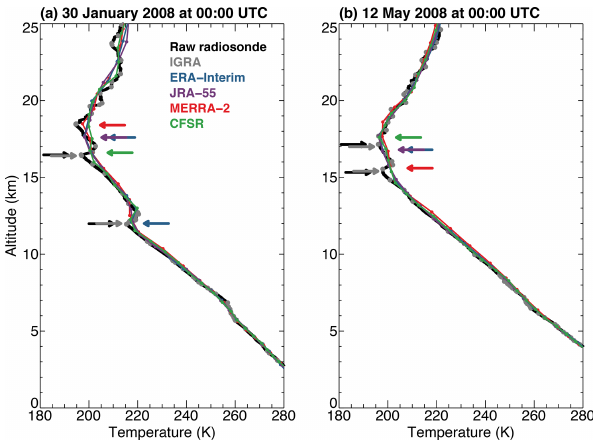
Figure 1. Example temperature profiles from the National Weather Service radiosonde site in Corpus Christi, Texas, at 00:00UTC on (a) 30 January and (b) 12 May 2008. Black lines show the origi- nal, full high-resolution radiosonde profile and gray dots show the reduced levels saved in the IGRA data. Coincident temperature profiles from ERA-Interim are shown in blue, JRA-55 in purple, MERRA-2 in red, and CFSR in green, with circles along these lines denoting each native model level. Colored arrows denote the loca- tions of primary and secondary lapse-rate tropopause altitudes cal- culated using each temperature